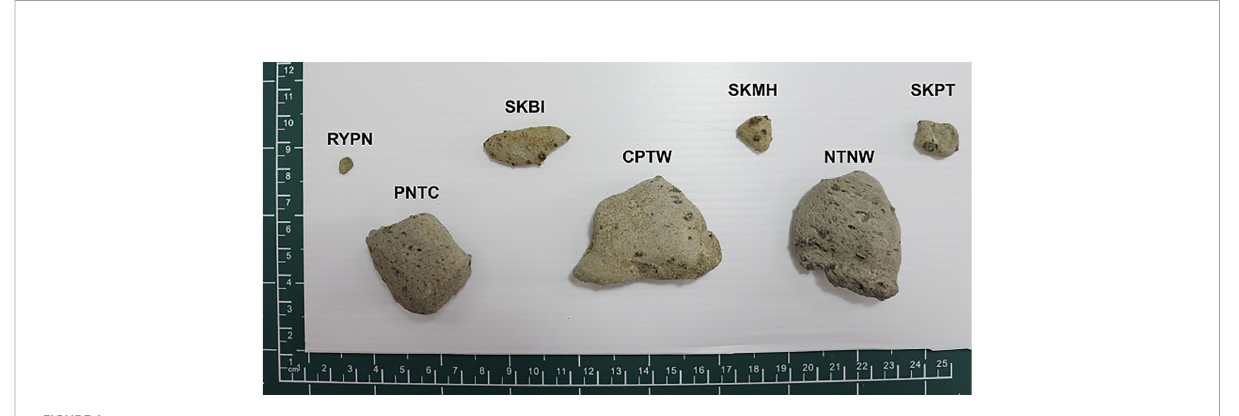
FIGURE 1 Example of pumice stone found on the coast of